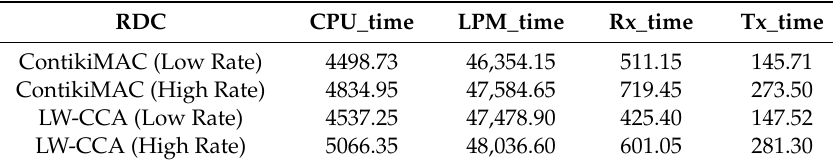
Table 8. Average of CPU ticks in SKY nodes.